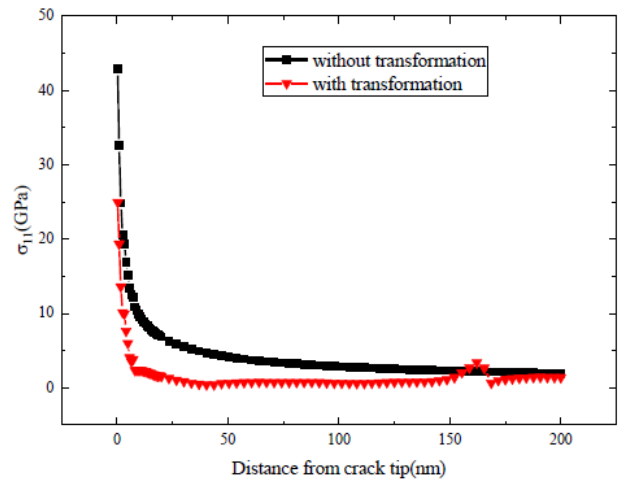
Figure 3. Distribution of the stress component σ 11 in front of the crack tip for the cases where the phase transformation is considered or ignored.